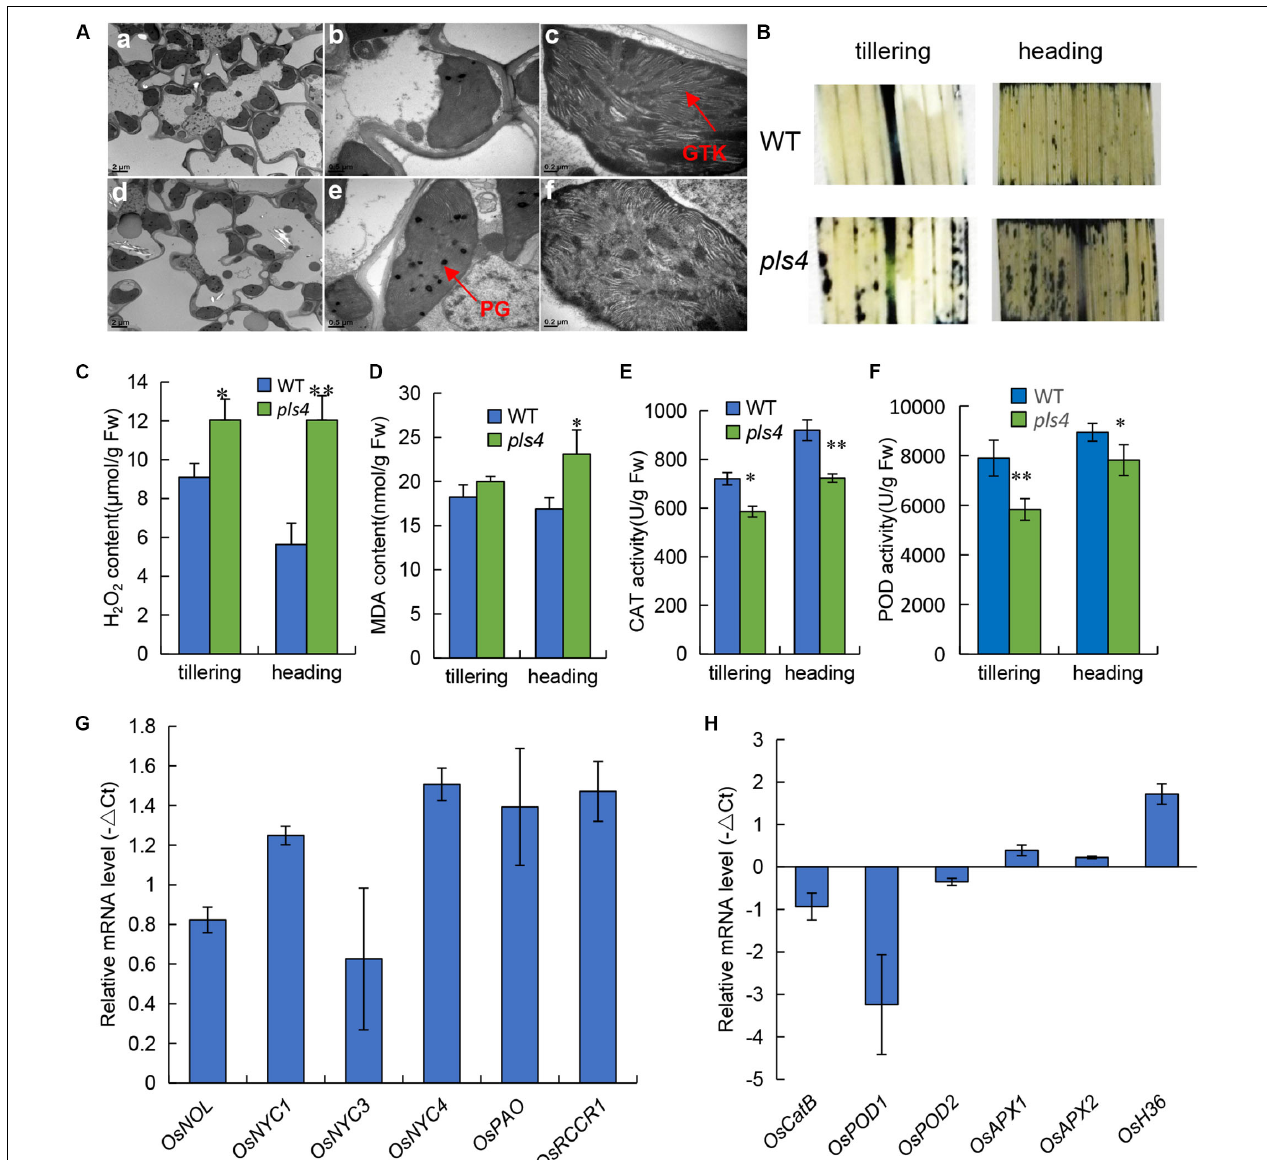
FIGURE 5 | Leaves of pls4 exhibit a severe senescence phenotype under natural conditions. (A) TEM analysis of the flag leaves of the WT and pls4 mutant at the heading stage. GTK, granum thylakoid; PG, plastoglobule. Bars = 2 µ m (a,d) , 0.5 µ m (b,e) , 0.2 µ m (c,f) . (B) Accumulation of O 2 − radicals in naturally senescence leaves, visualized by staining with NBT. (C–F) H 2 O 2 and MDA contents, CAT and POD activity in the WT and pls4 mutant at the tillering and heading stages. The data presented are the means ± SDs of three biological replicates. * P < 0.05; ** P < 0.01 (Student’s t -test). FW, fresh weight. (G) Changes in transcript levels of Chl degradation-associated genes in the leaves of the WT and pls4 mutant at the tillering stage. The genes are as follows: OsNOL ( LOC_Os03g45194 ) and OsNYC1 ( LOC_Os01g12710 ), two short-chain dehydrogenase/reductases, represent Chl b reductases; OsNYC3 , which encodes an α / β hydrolase-fold family protein ( LOC_Os06g24730 ); OsNYC4 , which encodes thylakoid formation 1, and is involved with chloroplast precursors ( LOC_Os07g37250 ); OsPAO , which encodes a pheophorbide oxygenase ( LOC_Os03g05310 ); and OsRCCR1 , which encodes reductase of Chl-like catabolites ( LOC_Os10g25030 ). (H) Relative expression of a set of genes associated with senescence in the WT and the pls4 mutant. The genes include the following: OsCatB , catalase ( LOC_Os06g51150 ); OsPOD1 ( LOC_Os01g22370 ) and OsPOD2 ( LOC_Os03g22010 ), two peroxidases; OsAPX1 ( LOC_Os03g17690 ) and OsAPX2 ( LOC_Os07g49400 ), two ascorbate peroxidases; and OsH36 , aminotransferase, senescence-induced protein ( LOC_Os05g39770 ). The data presented are the means ± SDs of three biological replicates.